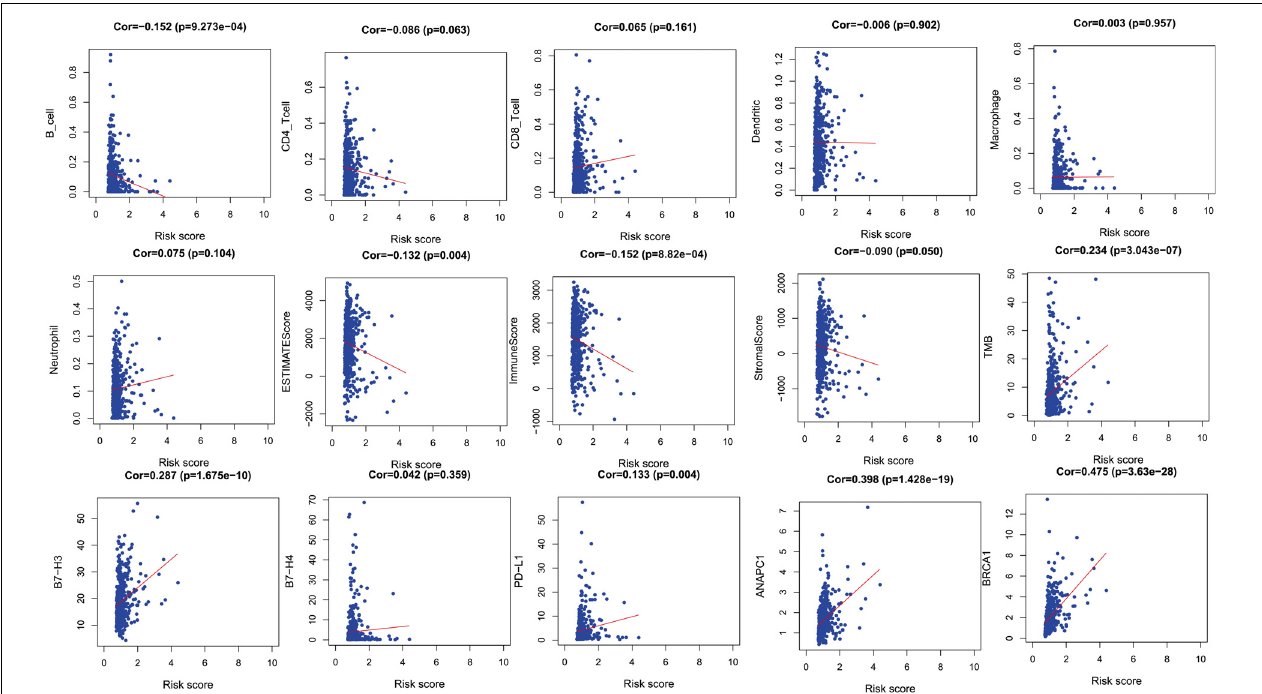
FIGURE 4 | The relationships between two PM-related genes and other prognostic features (immune checkpoints, cell proliferation related genes, etc.). PM, platelet and immunity.